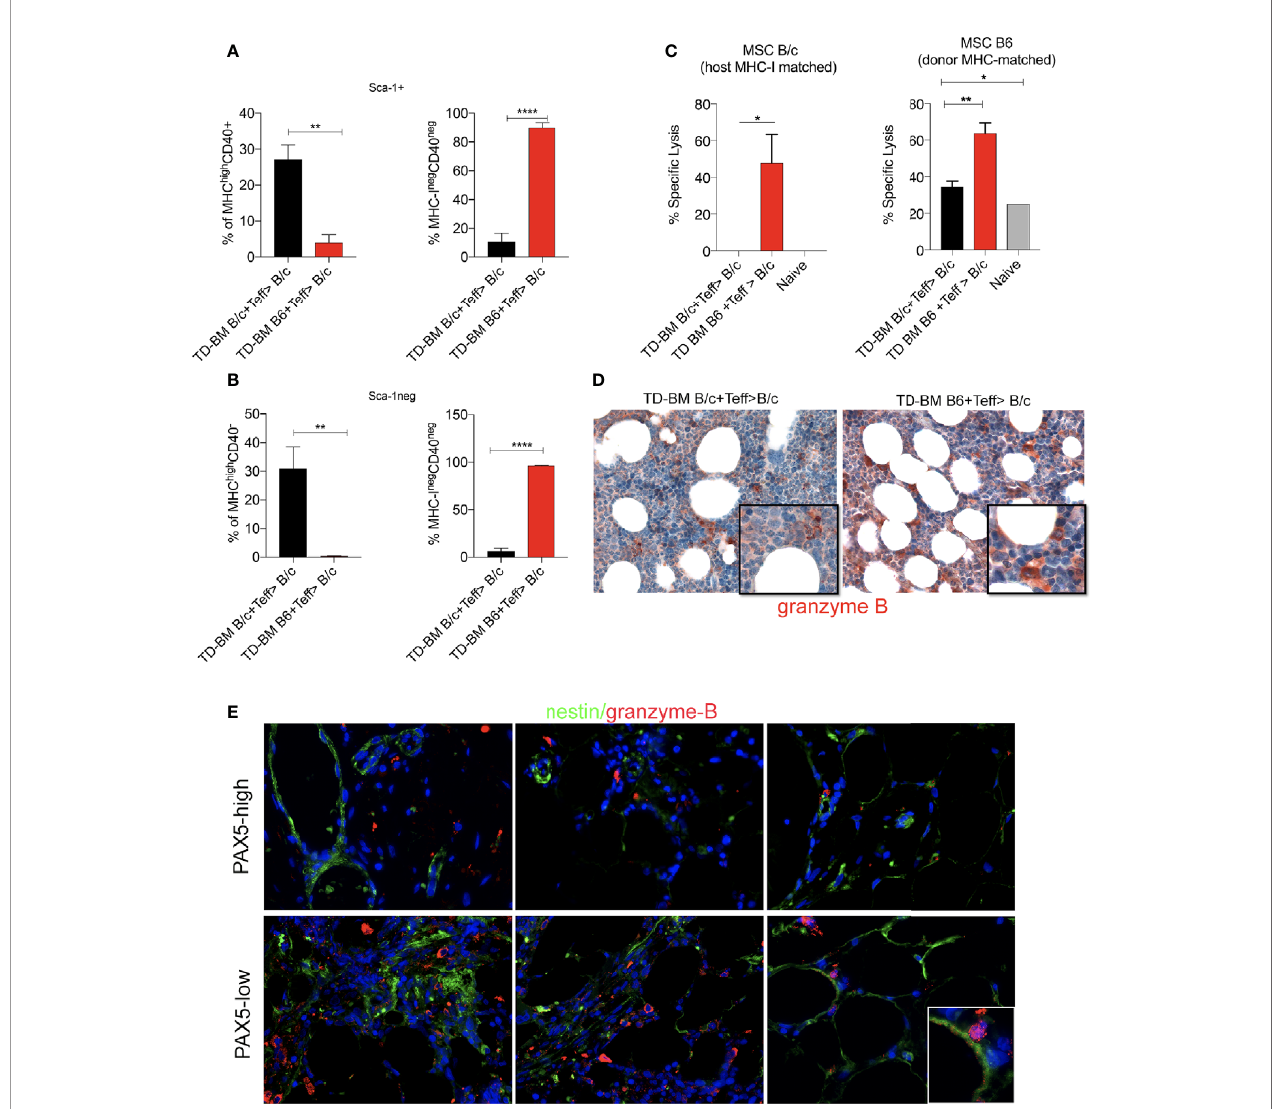
FIGURE 7 | Downregulation of CD40 expression in the BM-MSCs of aGVHD mice. (A) Frequency of MHC high CD40+, MHC neg CD40 neg BM-MSCs in the Sca-1+ gate of Lin-CD44+CD29+ BM-MSCs in aGVHD (TD-BM B6 + Teff>BALB/c) vs control (TD-BM BALB/c + Teff>BALB/c) mice. The analysis was performed at 14 days post-transplantation. **p < 0.005, ****p < 0.0001, compared according to Student ’ s t test (n=3/group). (B) Frequency of MHC high CD40+, MHC neg CD40 neg BM- MSCs in the Sca-1 negative gate of Lin-CD44+CD29+ BM-MSCs in aGVHD (TD-BM B6 + Teff>B/c) vs control (TD-BM B/c + Teff>B/c) mice. The analysis was performed at 14 days post-transplantation. **p < 0.005, ****p < 0.0001, compared according to Student ’ s t test. (n = 3/group). (C) Cytotoxicity assay performed on MSCs incubated with splenocytes freshly isolated from aGVHD (TD-BM B6 + Teff>B/c) or from controls (TD-BM B/c + Teff>B/c), *p < 0.05, **p < 0.005; (D) Representative granzyme B IHC staining of BM biopsies from aGVHD mice (TD-BM B6 + Teff>B/c) compared to that of controls (TD-BM B/c + Teff>B/c) (**p< 0.005, one-way ANOVA, Tukey ’ s multiple comparison). (E) Representative double-marker immuno fl uorescence analysis for granzyme B (red) and nestin (green) showing the co-localization between granzyme B and nestin+ elements in PAX-5-low